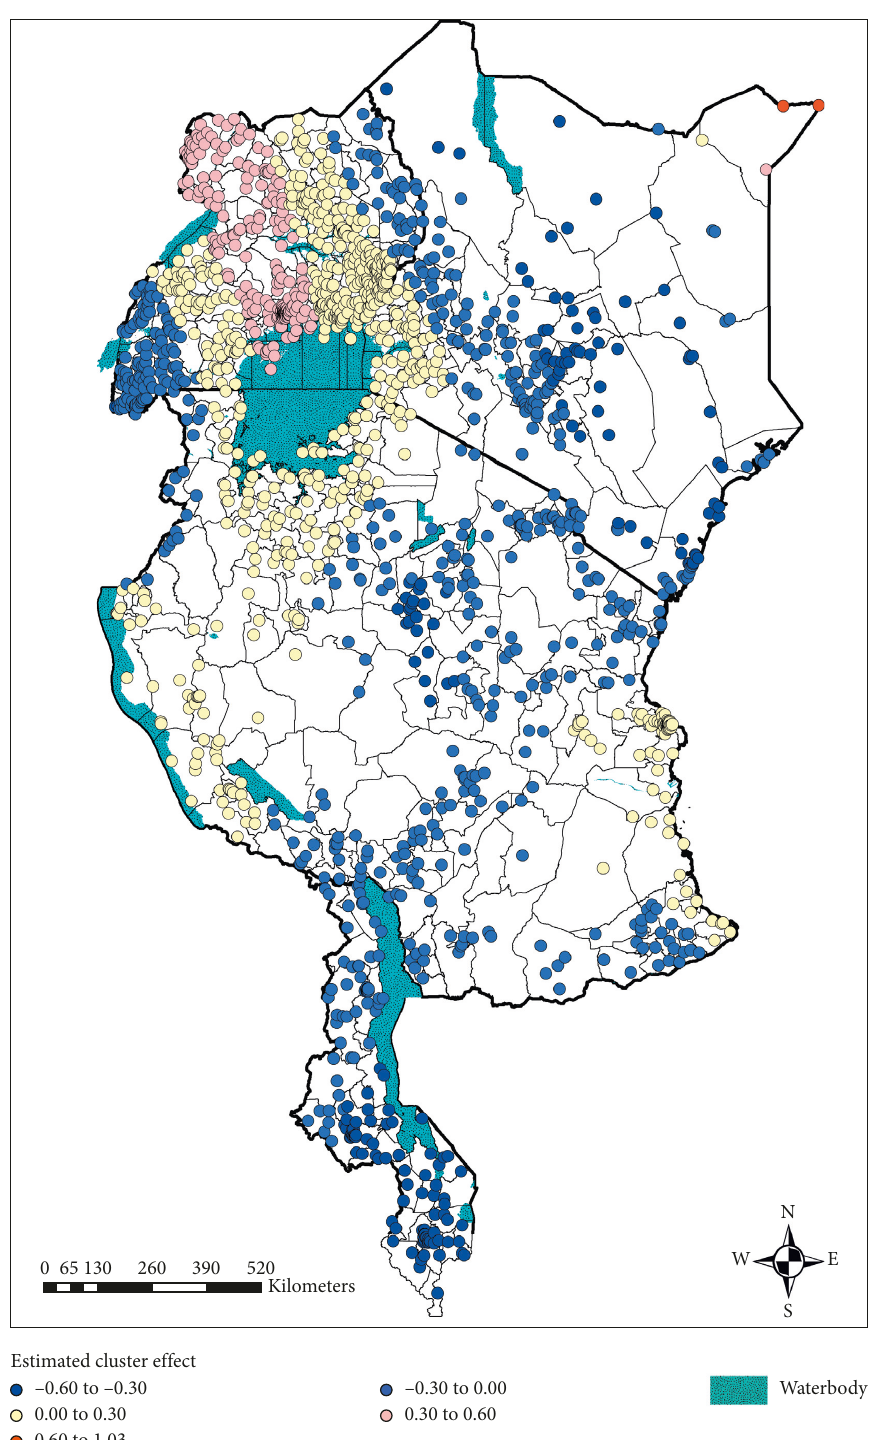
Figure 4: Estimated cluster-level spatial effect on the log-odds of anaemia (top left: Uganda; top right: Kenya; middle: Tanzania; and bottom: